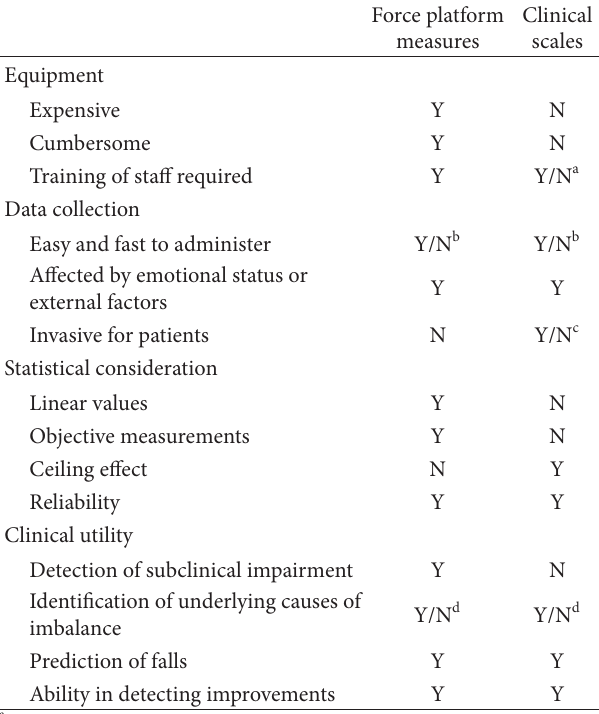
Table 2: Summary of pros and cons of force platform measures and clinical